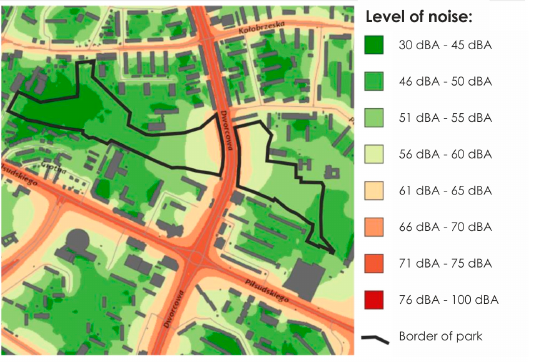
Figure 8. Acoustic map within the boundaries of the Kusoci ń skiego Park. Source: Own elaboration based on Acoustic Map of Olsztyn [93].